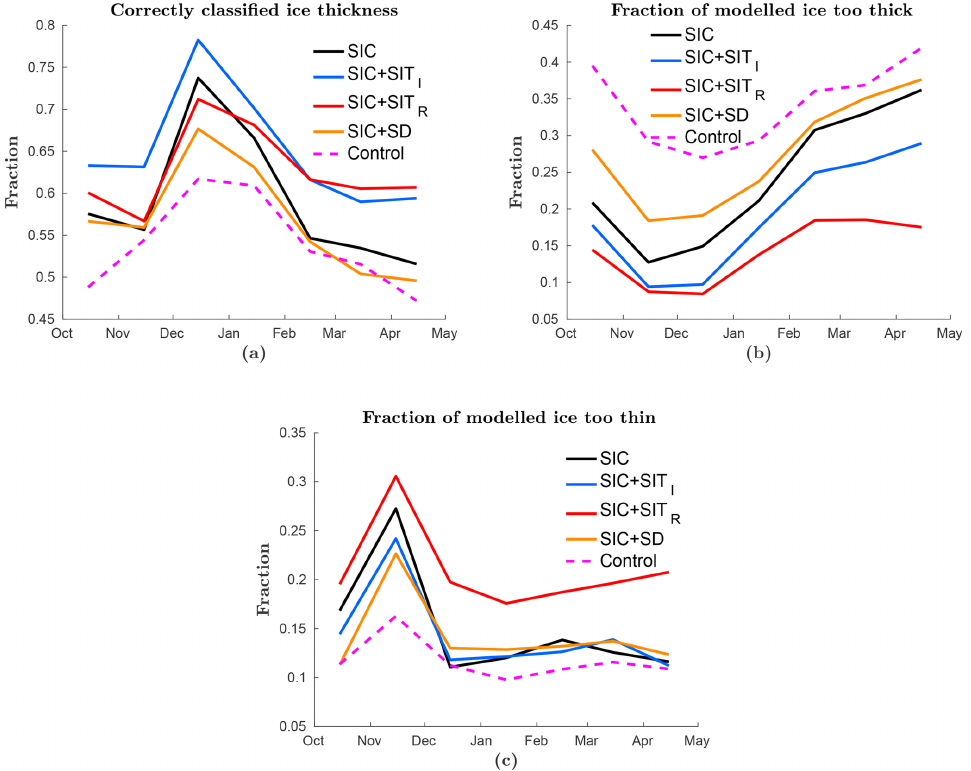
Figure 6. The monthly mean SIT averaged over all ensemble members is classified into four thickness categories and compared to the CryoSat-2-SMOS SIT observation product. The fraction of grid cells are shown with (a) correctly classified thickness category, (b) too thick ice, and (c) too thin ice. As in Fig. 2 the coloured lines represent different experiments.